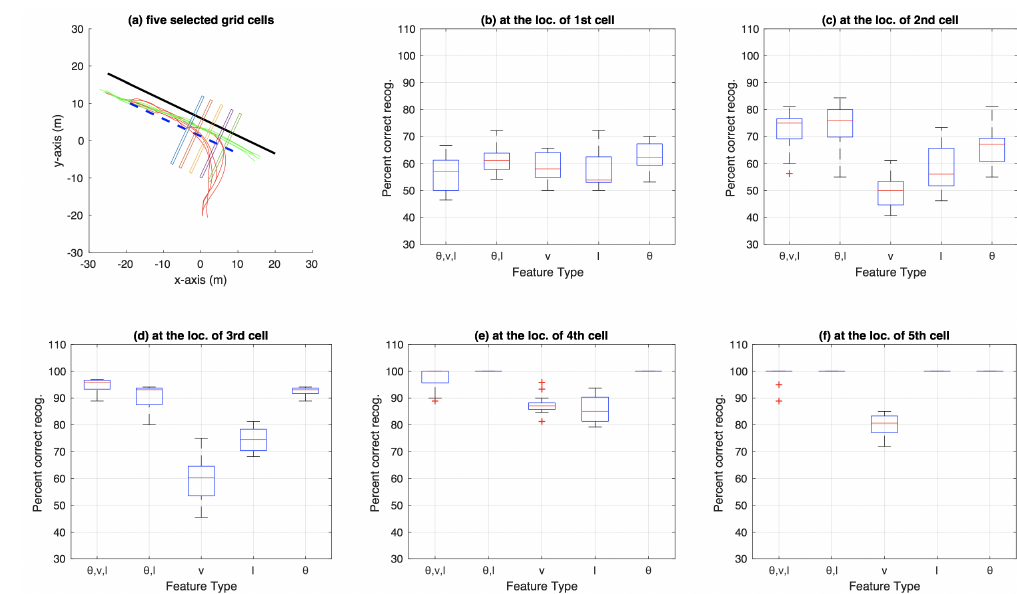
Figure 11. Aggregate results for car-turning dataset using decision